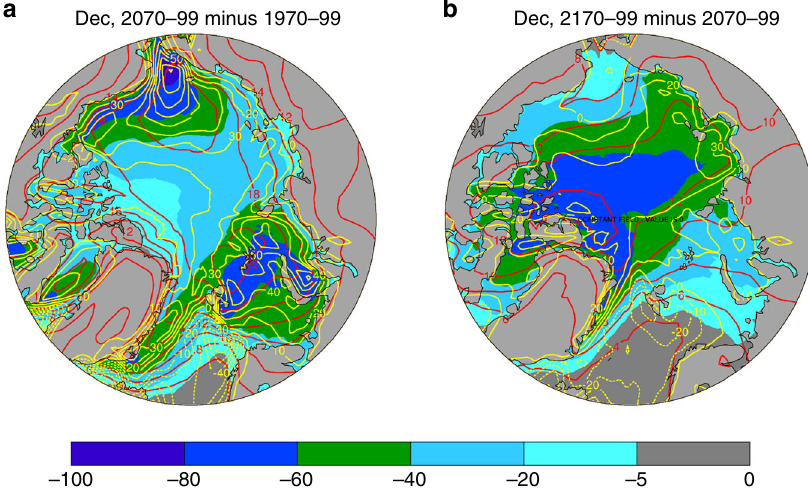
Fig. 5 Centennial changes from CMIP5 models. a from 1970 – 1999 to 2070 – 2099 and b from 2070 – 2099 to 2170 – 2199. Shown are changes in December sea-ice concentration (SIC, %, color shading), air temperature (Tas, °C, red contours, interval = 2), and latent and sensible heat fl uxes (LH + SH, W m − 2 , yellow contours, interval = 10). Dashed contours are for negative values. Based on the ensemble mean of nine simulations from nine CMIP5 models under the historical and RCP85 scenarios. The spatial pattern correlations are: r (SIC, Tas) = − 0.79, r (SIC, LH + SH) = − 0.68, r (Tas, LH + SH) = 0.62 in a , and r(SIC, Tas) = − 0.85, r (SIC,LH + SH) = − 0.65, r (Tas, LH + SH) = 0.60 in b . Surface net energy fl ux change (not shown) is similarly correlated with the SIC and Tas changes, while the upward LW fl ux change (not shown) is highly correlated (r ≈ 0.90) with the Tas change. These correlations have a p -value well below